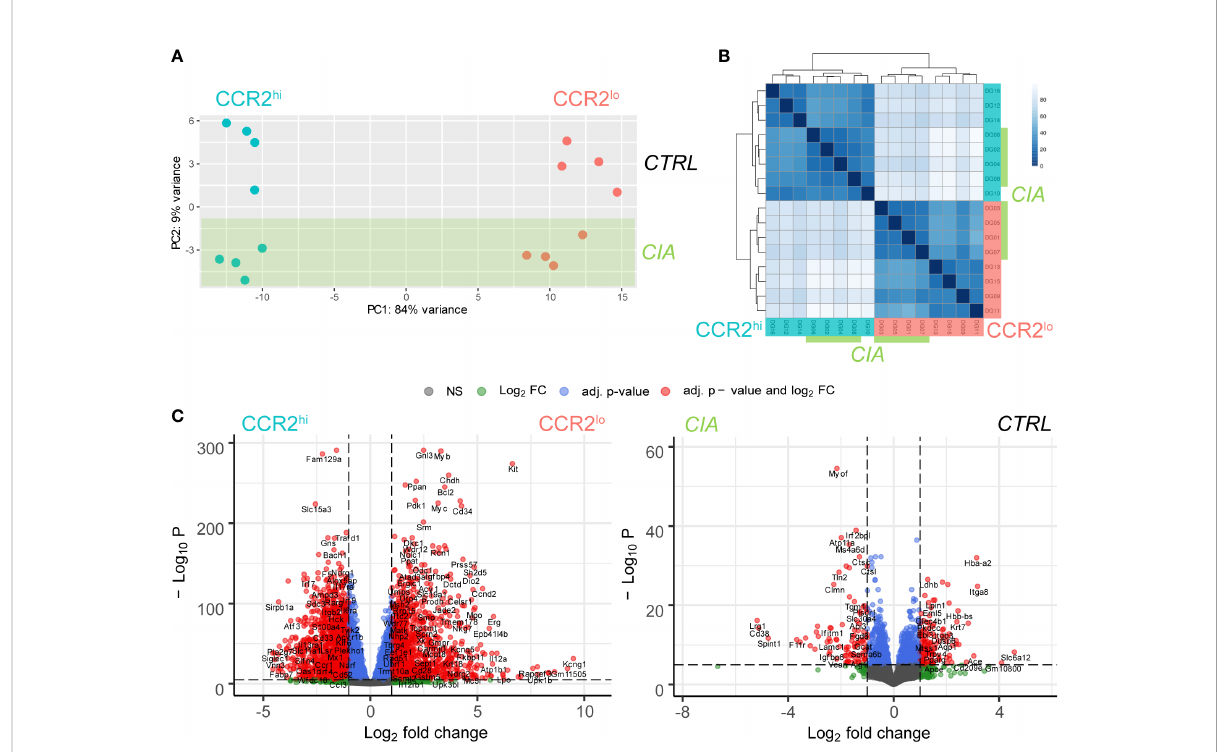
FIGURE 2 Distinctiveness of transcriptome clustering in CCR2 hi and CCR2 lo osteoclast progenitor (OCP) subsets. (A) Principal component analysis (PCA) performed based on the expression of the top 50 variable genes from RNA sequencing data in all samples. Dots represent individual samples, color denotes the subset: CCR2 hi in cyan and CCR2 lo in red, while the samples belonging to the intervention group, collagen-induced arthritis (CIA), are shaded in green. (B) Sample similarity analysis heatmap where the shade of the color represents similarity in gene expression between samples. Samples labeled 1-8 are derived from CIA mice (marked green), and samples labeled 9-16 from control mice (CTRL). Odd numbered samples represent the CCR2 hi subset (cyan), while even numbered samples represent the CCR2 lo subset (red) of OCPs. (C) Volcano plots showing the comparison of gene expression between CCR2 hi and CCR2 lo subsets, as well as the comparison between CIA and CTRL groups. Negative logarithm of Benjamini-Hochberg correction adjusted p value (-Log 10 P) for each gene is shown in relation to the logarithm of fold change